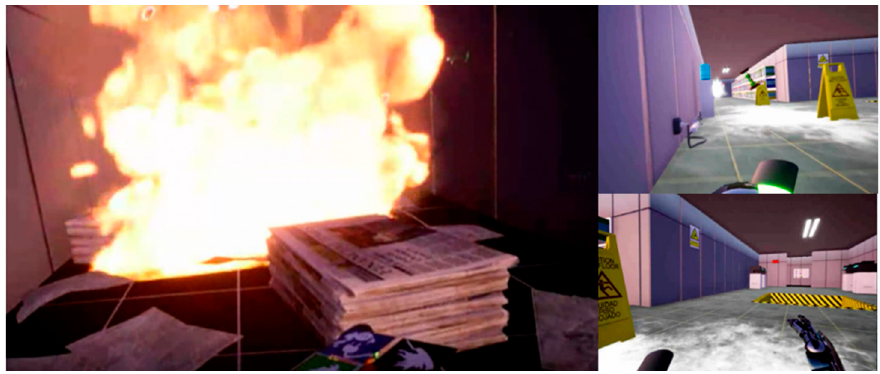
Figure 6. Example of hazards.